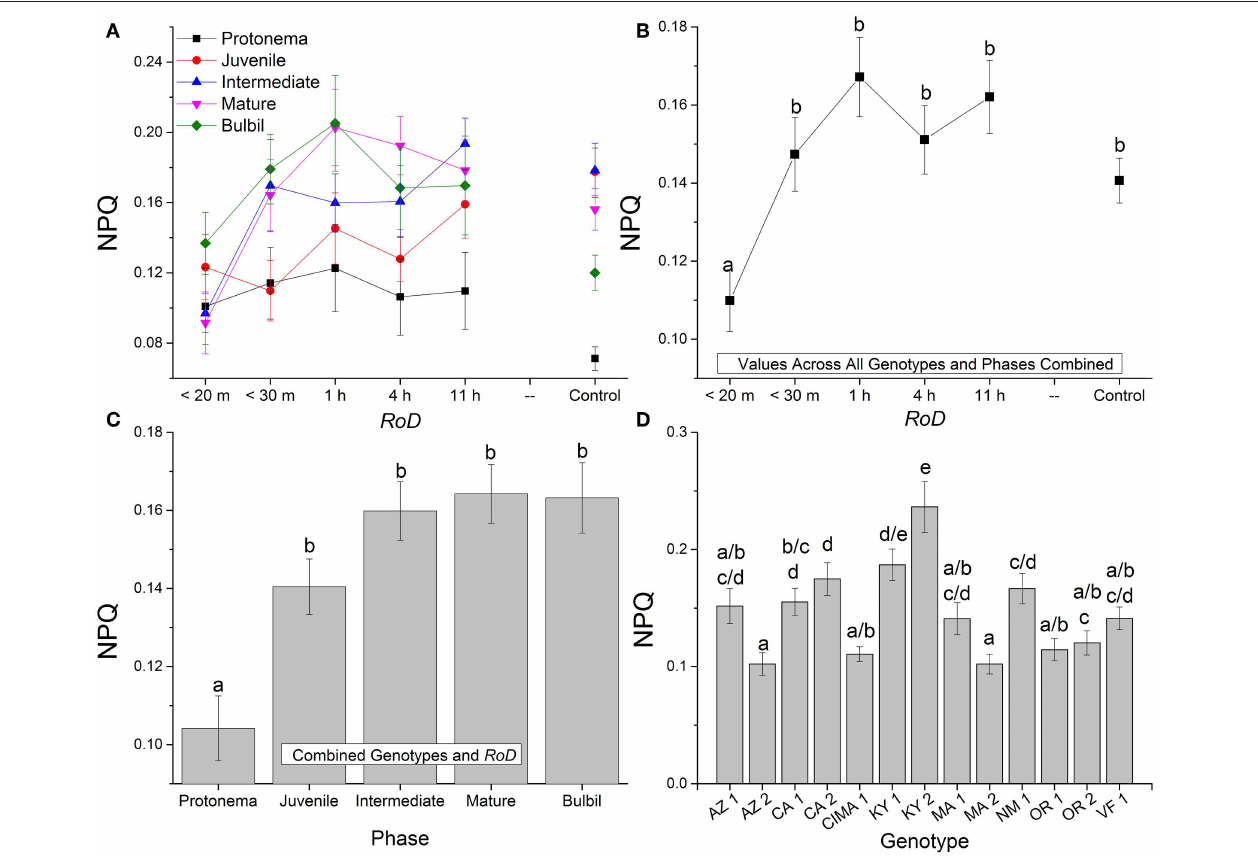
FIGURE 3 | Bryum argenteum NPQ response variables. Panel of images showing Bryum argenteum NPQ response variables 24h post rehydration for the treatment combinations indicated, error bars represent ± 1 SE, and lowercase letters represent homogeneous subsets established at an α of 0.05. (A) Two-way interaction between rate of drying (RoD) and life phase ( n = 65), (B) Main effect of RoD among life phase and ecotypes combined ( n = 390), (C) Main effect of life history phase among RoD and ecotype ( n = 390), (D) The effect of ecotype with all life phases and RoD treatments combined ( n = 150). RoD, Rate of